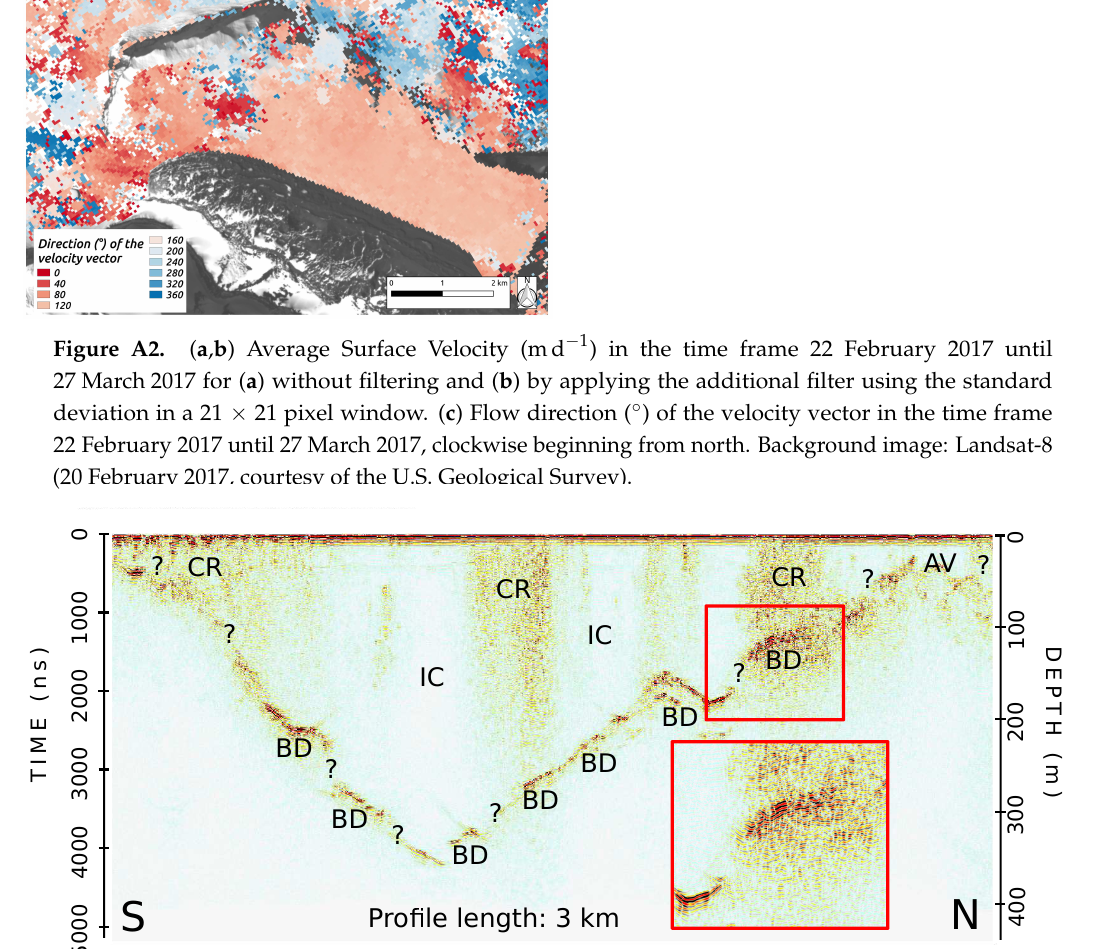
Pro le length: 3 km S (cid:1) Figure A3. Processed radargram used for interpretation with the main materials and structures, including bedrock (BR), ice (IC), crevasses (CR), and areas influenced by ice and snow avalanches (AV). Regions in the profile indicated with a question mark were discarded due to ambiguous backscatter information. The profile is from the next flight path up from flux gate G6 (Figure 2). The close-up in the bottom right corner shows a region (marked with the red rectangle) with gaps in the bedrock reflector, crevassed area, and the loss of a clear reflector in avalanche area at the right